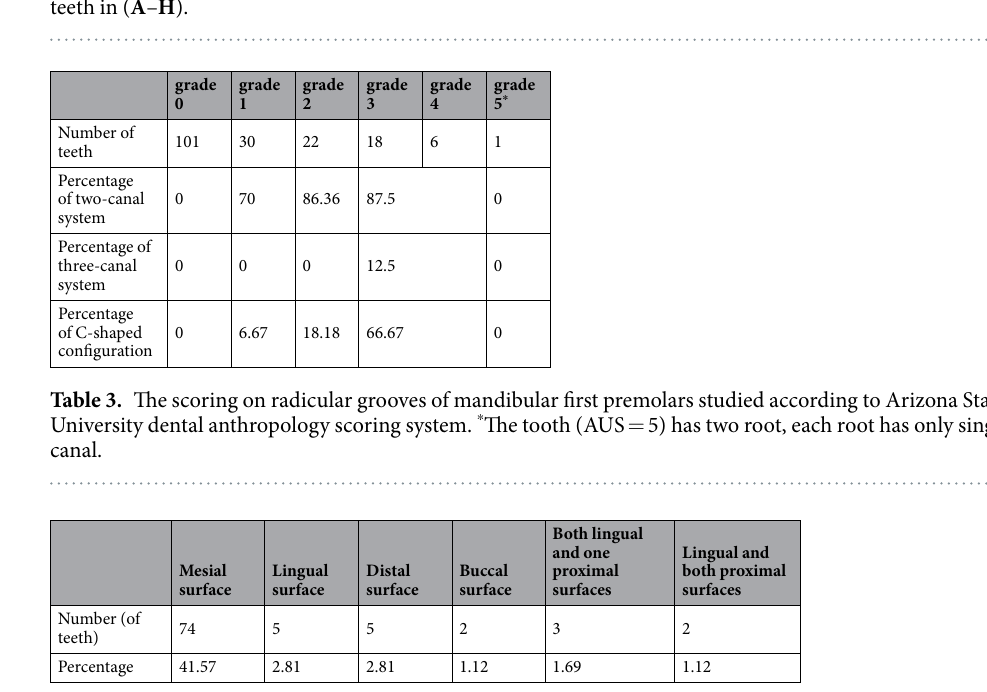
Figure 1. The micro-CT images showing external root anatomy and corresponding inner root canal morphology. The teeth were scored for radicular grooves variations according to ASUDAS. ( A ) grade 0, ( B,C ) grade 1, ( D ) grade 2, ( E,F ) grade 3, ( G,H ) grade 4, ( I–P ) the corresponding inner root canal morphology for teeth in ( A – H ).